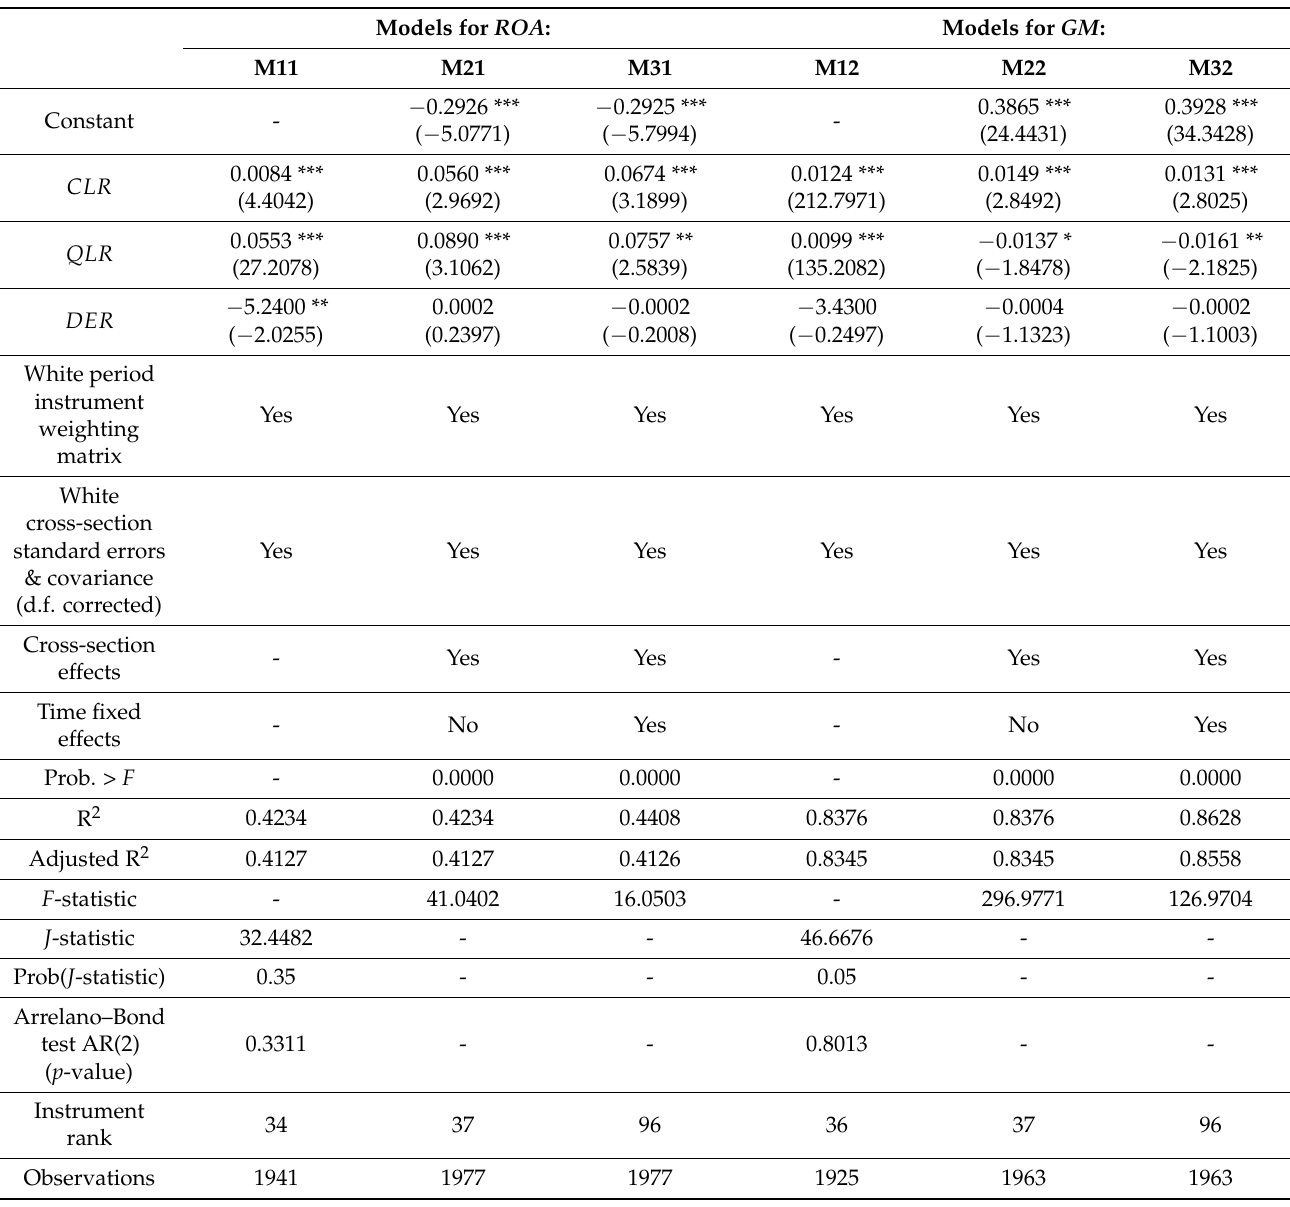
Table 3. Econometric models estimations corresponding to the dependent variables return on assets ( ROA ) and gross margin ratio ( GM